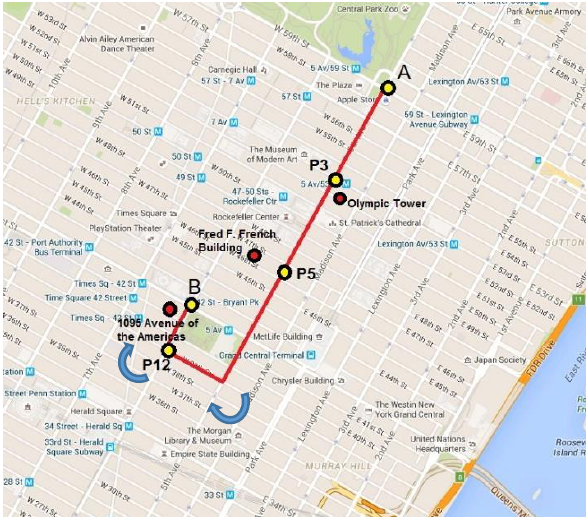
Figure 5. The route with search points P3, P5 and P12, along side the three landmarks that were retrieved for these search points (source: Google